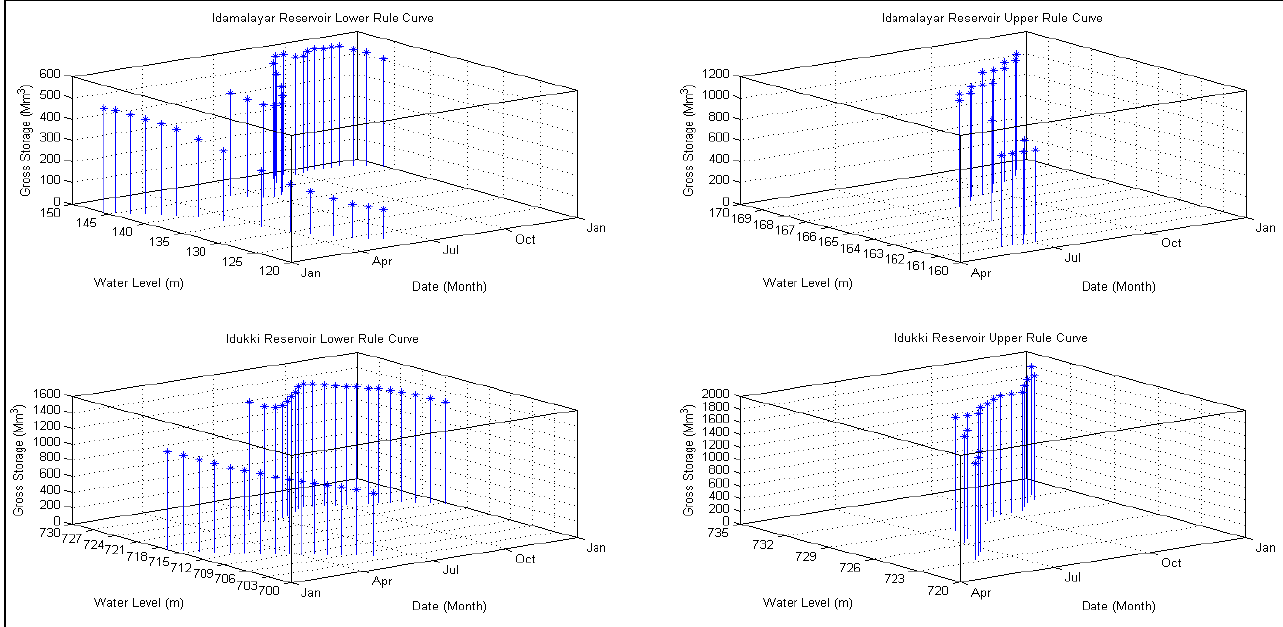
Figure 6. Idamalyar and Idukki available lower and upper rule curve.